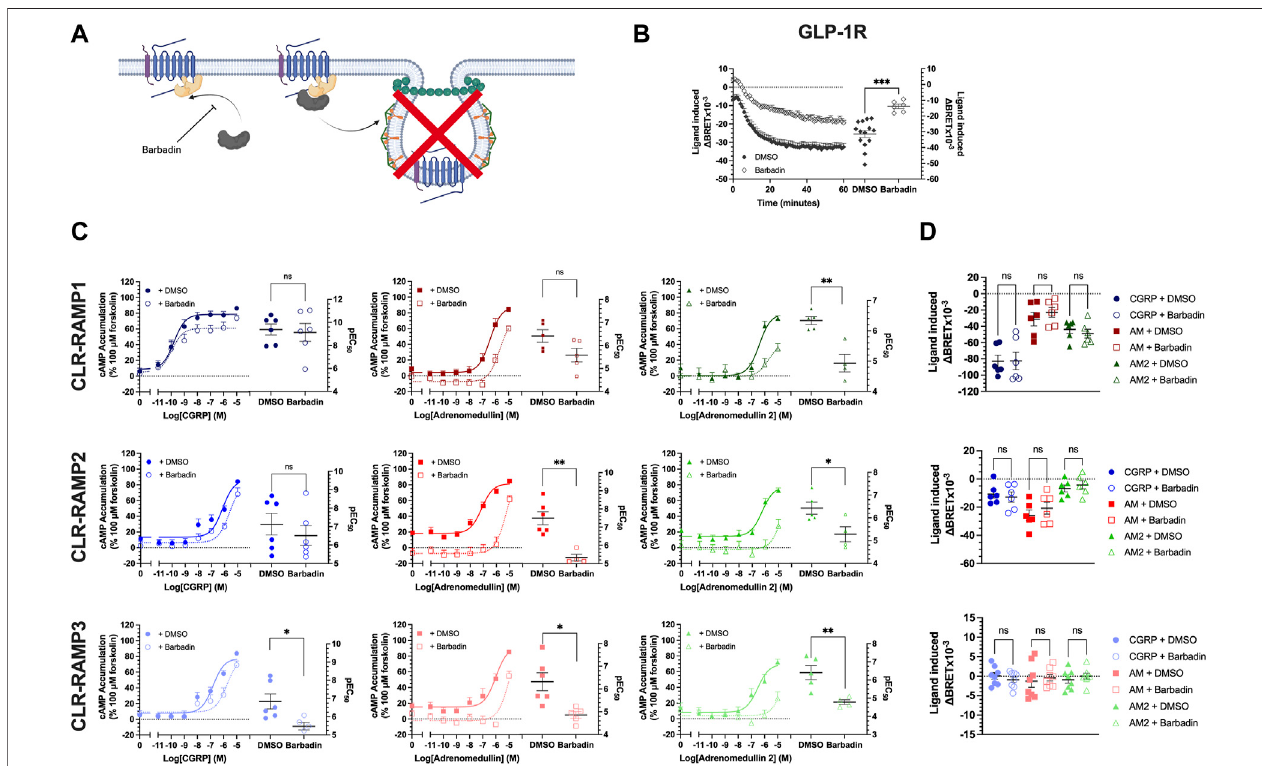
FIGURE 3 | Barbadin signi fi cantly impairs cAMP accumulation at CLR-RAMP complexes in an internalisation independent manner. (A) Schematic (created with BioRender.com)indicatingtheroleofbarbadin,asmallmoleculeinhibitorofthe β -arrestin-AP2complex. (B) EffectsofbarbadinonanotherClassB1GPCR,theGLP1R. (C) cAMP accumulation mediated by each peptide agonist following a 30 min pretreatment with DMSO (closed symbols, solid line) or 100 μ M barbadin (open symbol, dottedline),forRAMP1,RAMP2,andRAMP3.Differencesin,andpotencyvaluesarereportedontheadjoiningscatterplots. (D) Effectof30 minpretreatmentwith DMSO (closed symbols) or barbadin (open symbols) on internalisation of CLR-RAMP1, RAMP2, or RAMP3. Statistical signi fi cance between vehicle (DMSO) and barbadin treated cells was determined, at p < 0.05, using Student ’ s t-test (*, p < 0.05; **, p < 0.01). Data are shown as mean with error bars indicating the SEM of n repeats where n = ranges between 3 and 6